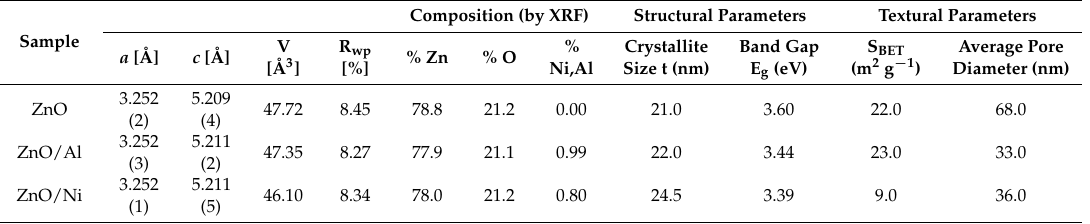
Table 1. Compositional, structural, and textural characteristics of the prepared samples. Sample